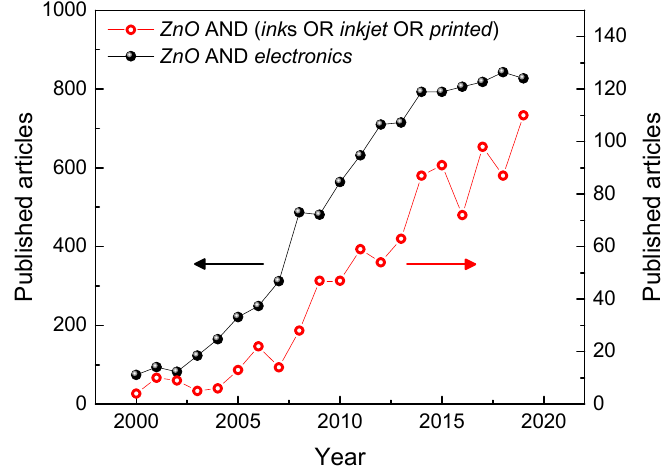
Figure 1. Published articles from 2000 to 2019 on “ZnO” and “electronics” (closed black symbols), and on “ZnO” and “inks”, or “inkjet”, or “printed” (open red symbols). Data extracted from Scopus database on 20 March